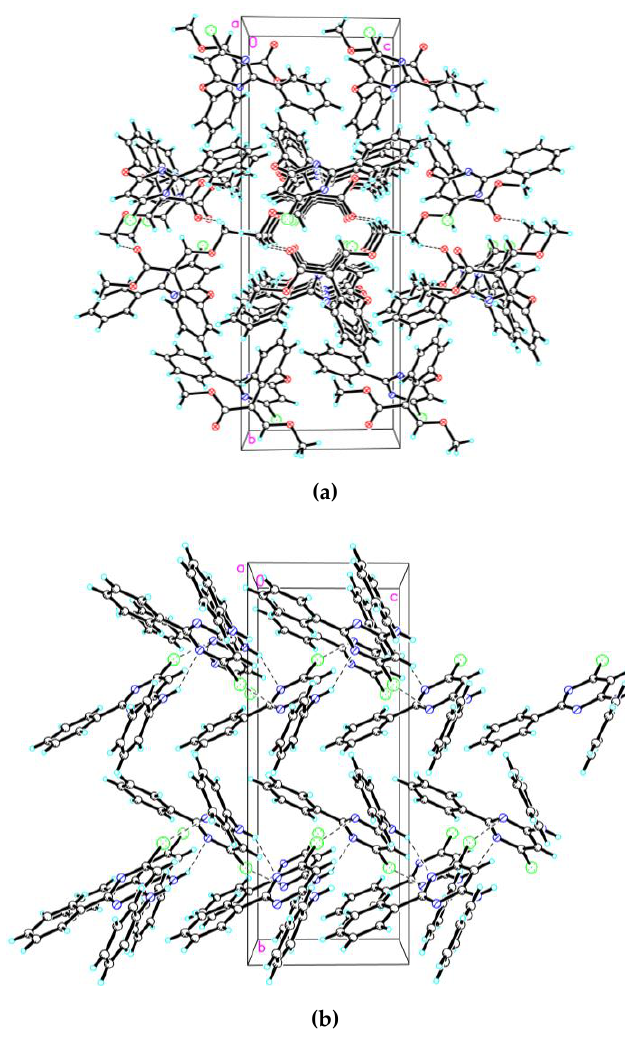
Figure 3. Packing diagram of compound 6 (3a ) and 7 (3b ). Dashed lines represent hydrogen bonds. Based on whole structural analysis, molecule 6, forms C – H···N (symmetry code: 1 − x, 1 − y, 1 − Table 4. Hydrogen bonding interactions in compound 7 . z) and C – H···O hydrogen bonding interactions (symmetry code: 1 + x, y, z) with the phenyl C atom (Table 4), to from three-dimensional networks. The C···N distances between donor (D) and acceptor (A) molecules were 3.341(6) Å for C(5) – H(5)···N(2), and 2.8711(16) Å for C(11) – H(11B)···O(3), respectively. The distances between hydrogen atom and acceptor atom were 2.53 Å for H(5)···N(2), and 2.30 Å for H(11B)···O(3), respectively. Both of the bond lengths were shorter than sum of van der Waals radii (2.66 Å for H(5)···N(2) and 2.63 Å for H(11B)···O(3)) [36]. As shown in Table 5, Table 5. Hydrogen bonding interactions in compound 6